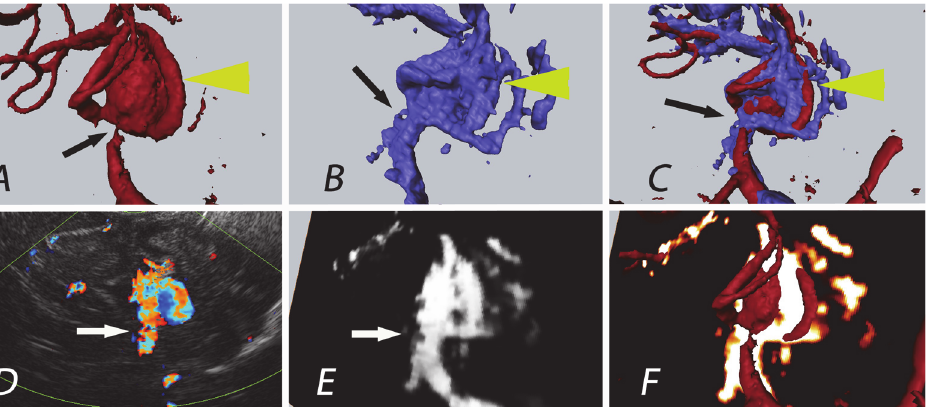
Fig 3. Patient 5: The yellow arrow indicates the aneurysm of the medial cerebral artery bifurcation; the black Arrow indicates the aneurysm origin/ neck; improved visualization of the aneurysm neck in 3D-ioUS (B) with narrow M1 segment of the medial cerebral artery due to high blood flow velocity in bifurcation marked with a white arrow (D, E).; rDSA (red), 3D-ioUS (blue, glow-orange), A: pre-clipping rDSA; B: pre-clipping 3D-ioUS; C: coregistration of A+B; D: pre-clipping duplex; E: MIP 3D-ioUS; F: coregistration of